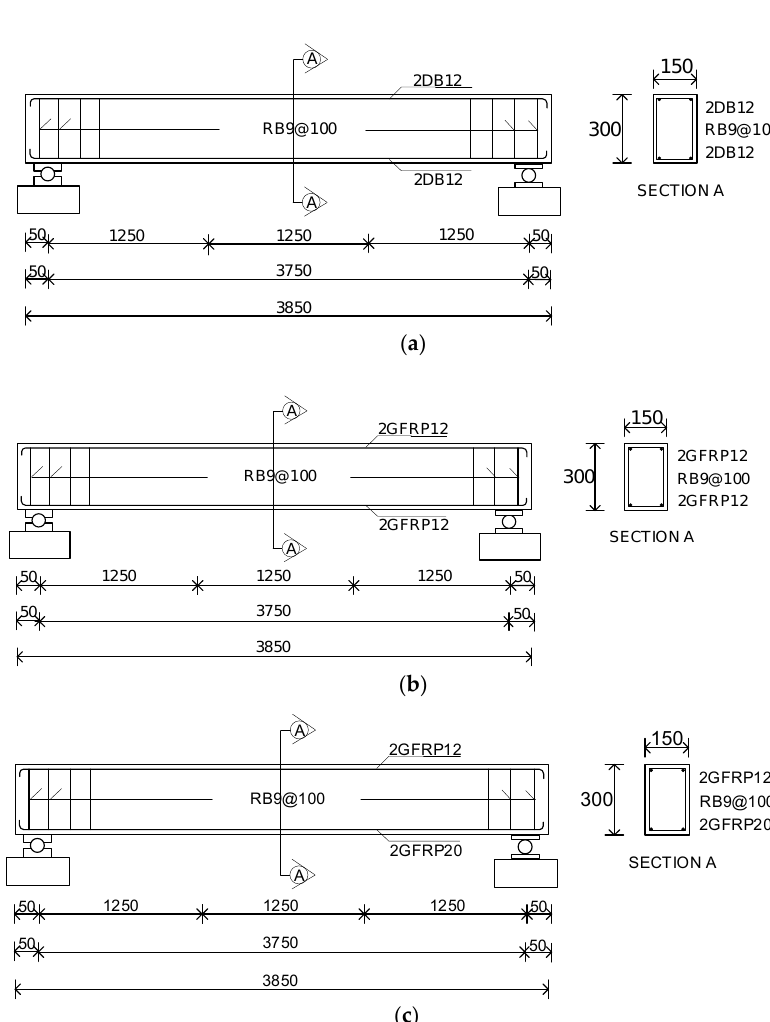
Figure 2. Beam details. ( a ) Beam RC12; ( b ) Beam BF12; ( c ) Beam BF20. Table 1. Details of test beams. Beam No.